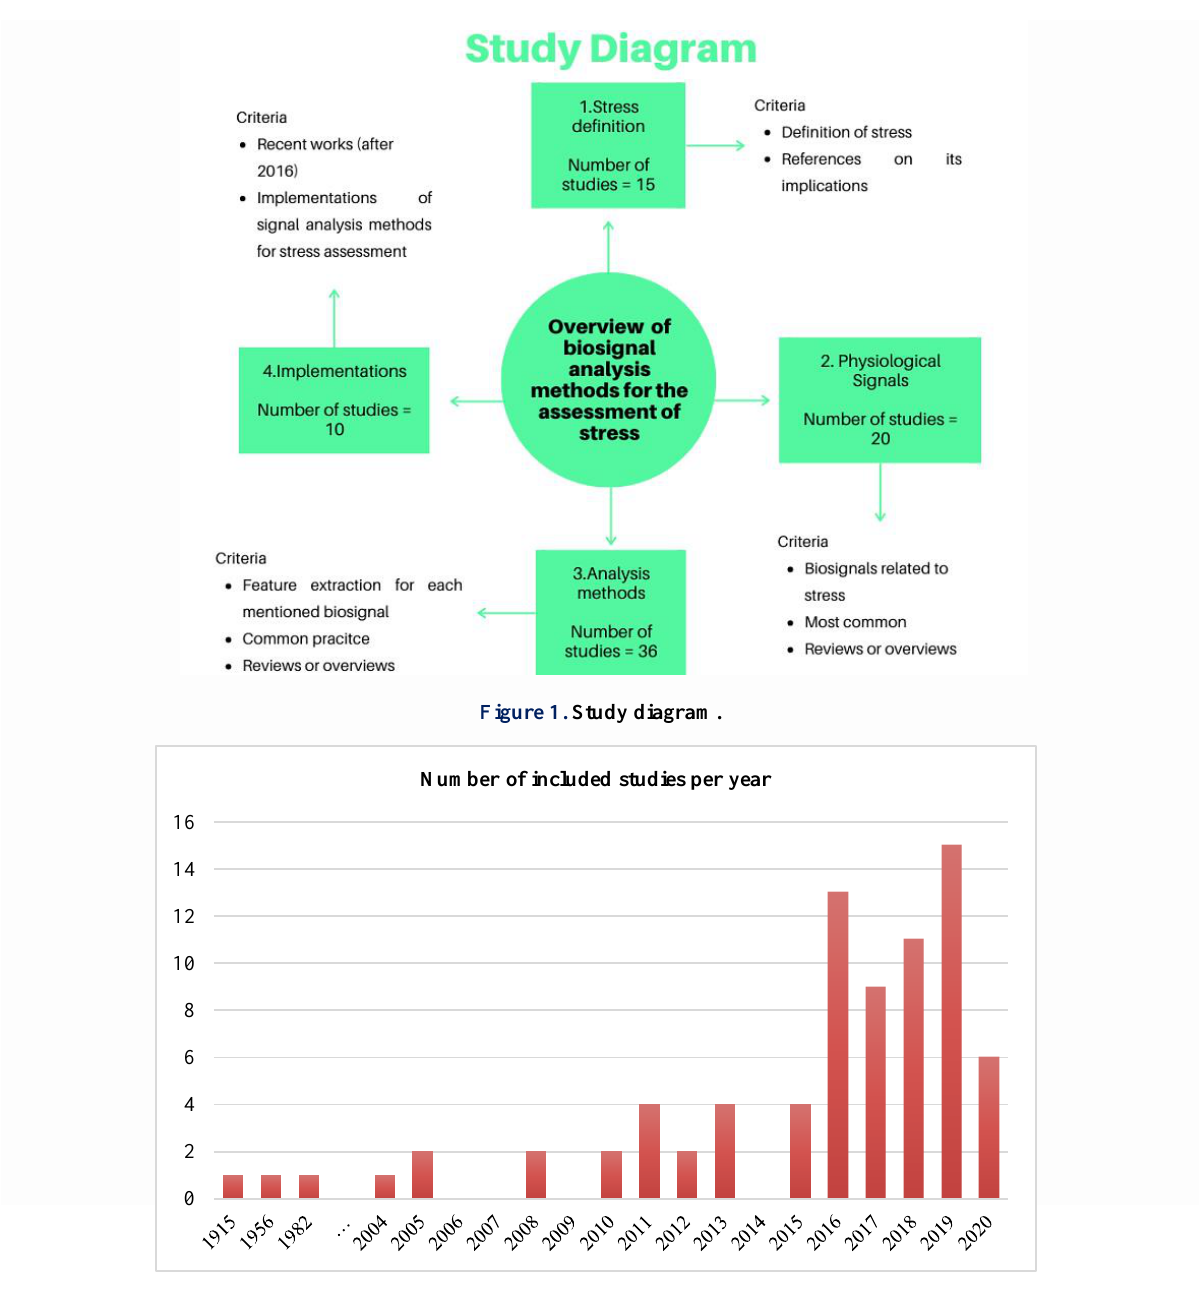
Figure 2. Number of included studies per